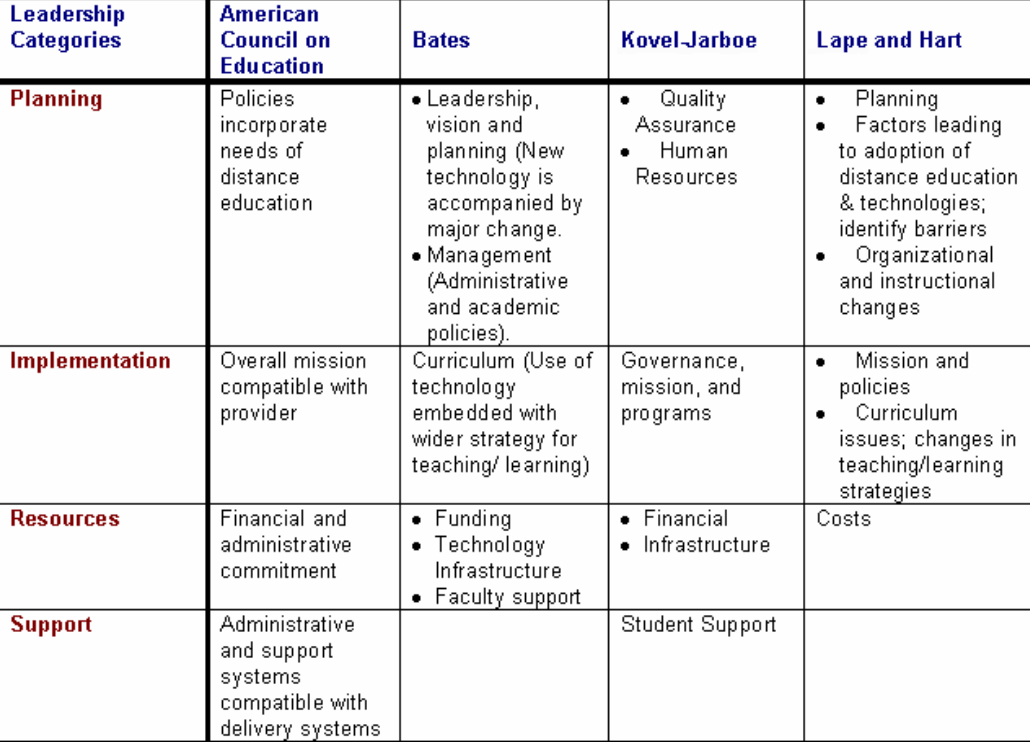
Table 1. Comparison of Categories and Authors' Descriptions: Examples of categories cited in